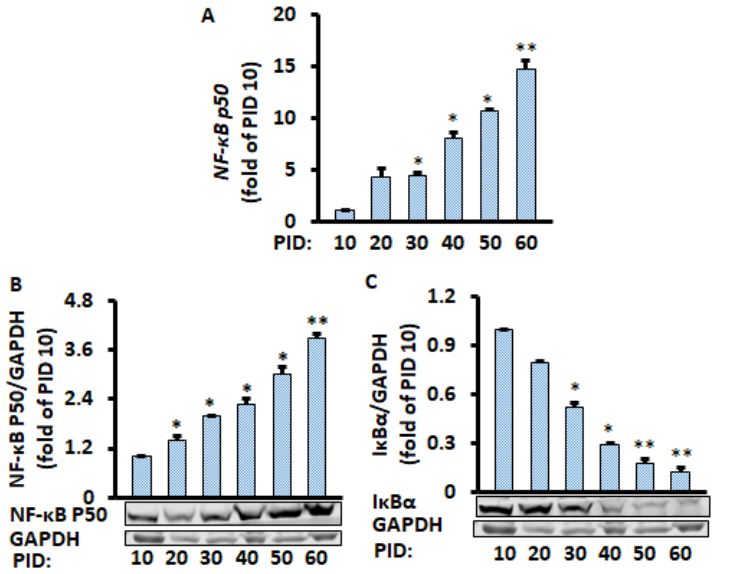
Figure 2. Time-course of changes in gene and protein levels during the 60 days of differentiated adipocyte in conditioned medium. Aging adipocytes chronologically increased NF- κ B p50 gene ( A ) and protein ( B ) expression while they decreased I κ B α protein level ( C ). Gene and protein levels were measured by RT-PCR and Western blot, respectively, and normalized by GAPDH and EEF2 genes. Data were analyzed using one-way ANOVA, and significant differences were further analyzed using Tukey’s test; * p < 0.05, ** p < 0.01 compared to PID 10.